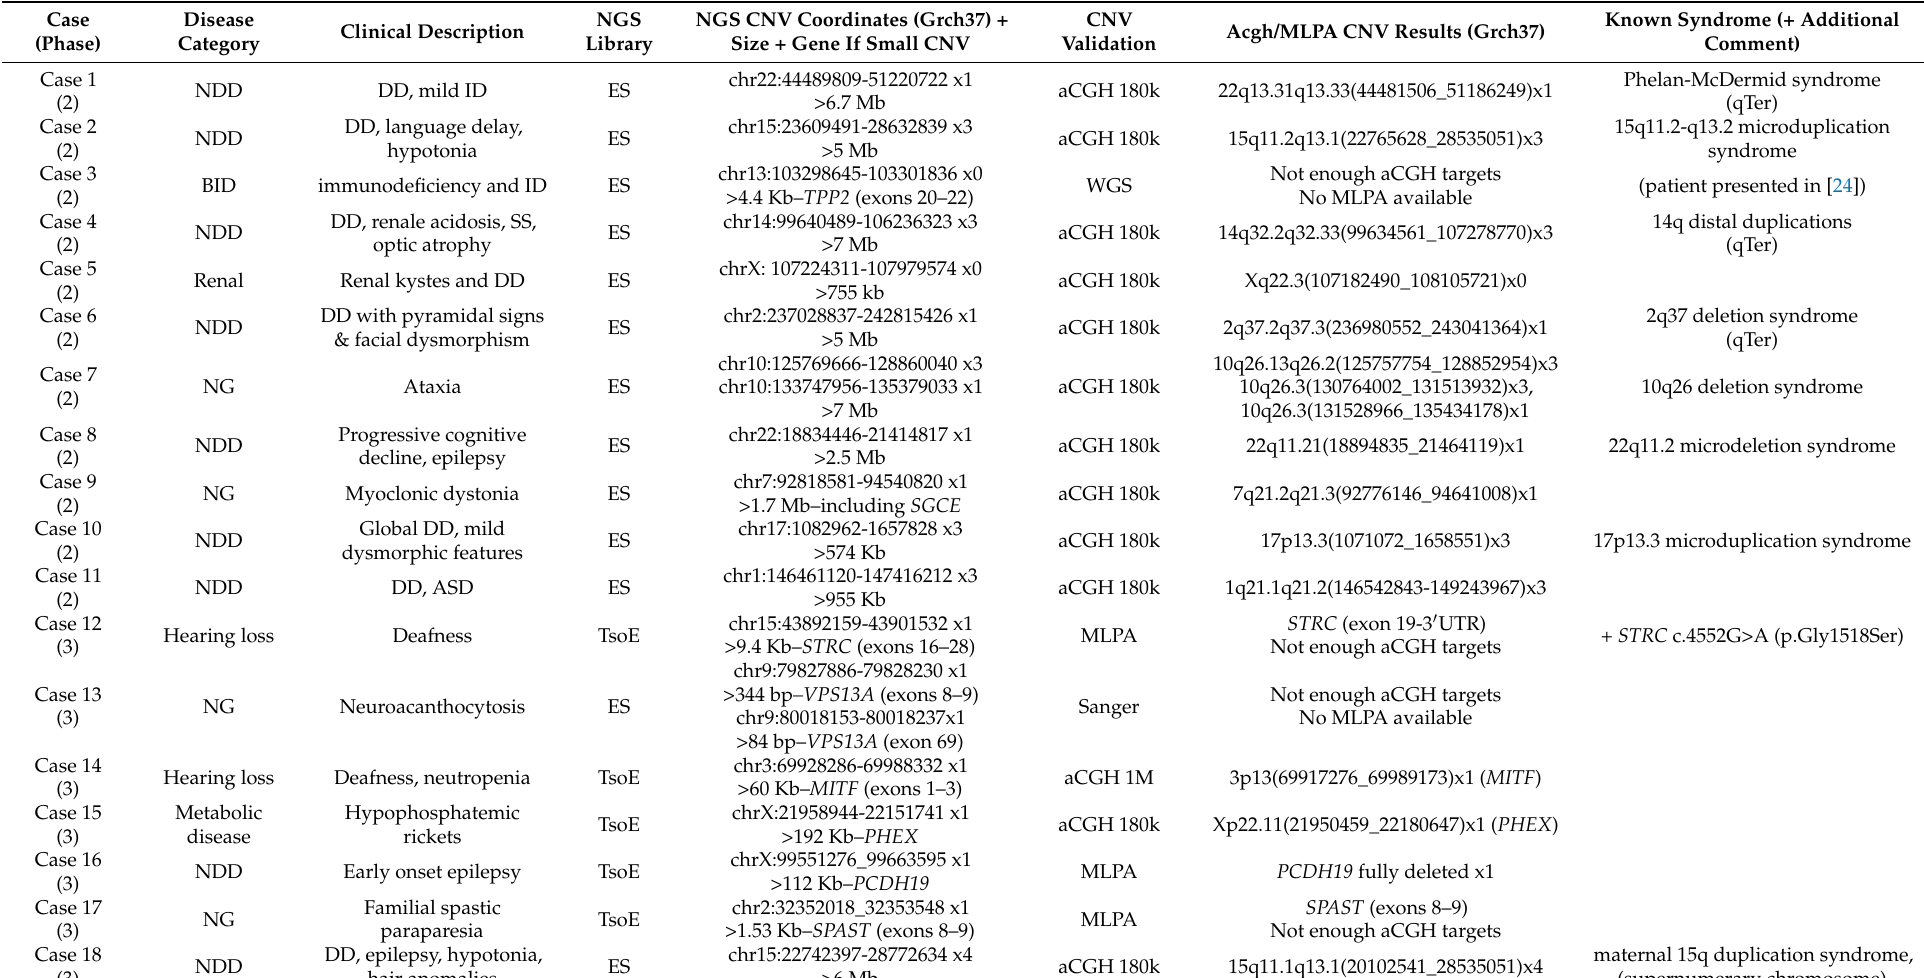
Table 1. List of patients with likely pathogenic and pathogenic CNVs detected by the NGS-based CNV